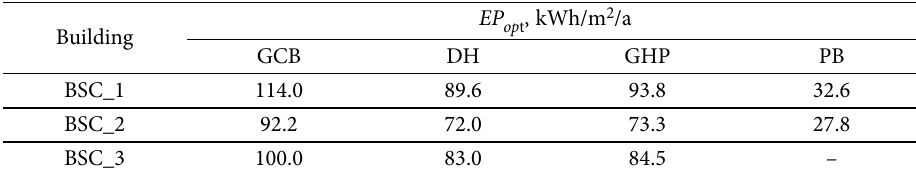
Table 4. Optimal level for the primary energy index for the analysed buildings and heat sources in- cluding the requirements regarding the building’s thermal insulation, kWh/m 2 /a